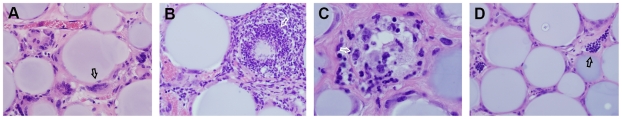
Histopathological changes in the parenchyma of a BluePort adjacent to sand fly bite-induced dermal eosinophilia.Images represent inflammatory changes observed 24 hours after exposure, for a second time, to the bite of sand flies on BluePort-associated skin. Arrows indicate: foreign-body giant cells (A), attack and destruction of CBa-beads by neutrophils (B) and macrophages (C), and lymphocytic infiltration of the BluePort parenchyma (D). Hematoxylin-eosin stain, 1000x magnification.